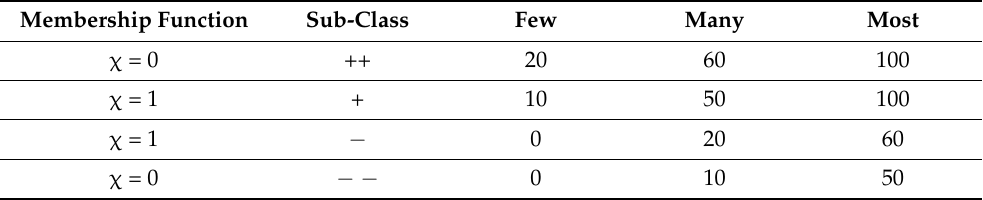
Figure 1. Membership function for descriptive language. Table 3. Membership function for translation of qualitative terms to